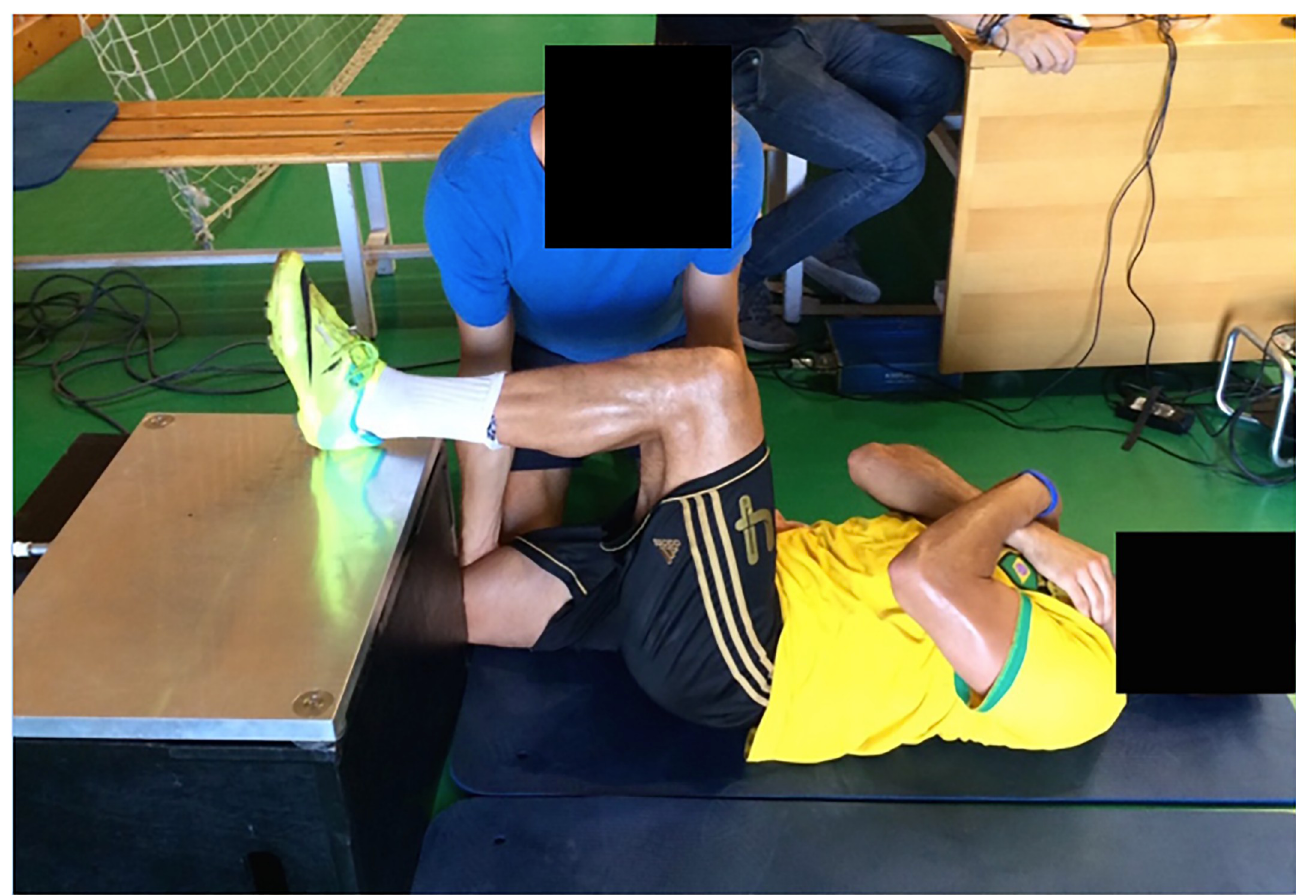
Fig 3. Supine 90˚:90˚ posterior chain test [15]. Modified Ball-Sport Endurance and Sprint Test (BEAST90 mod